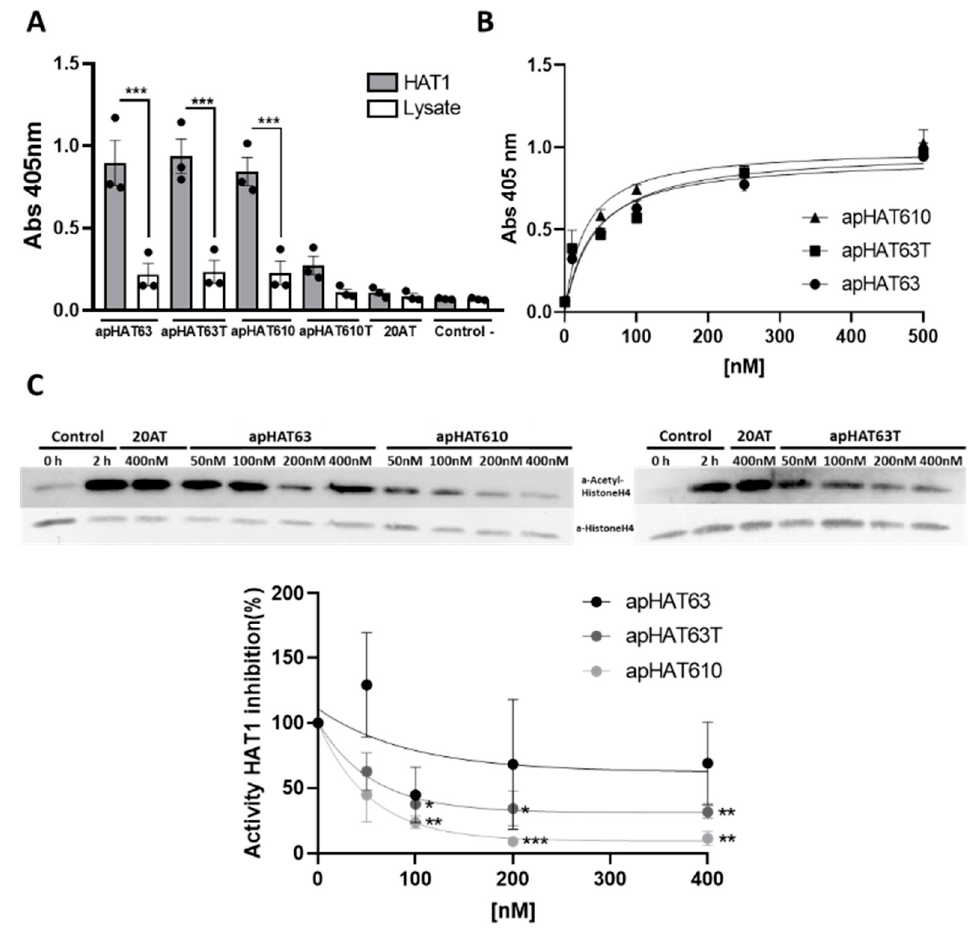
Figure 4. Characterization of the interaction of the selected aptamers with HAT1. ( A ) ELONA of the biotin-labeled synthetic aptamers at 40 nM (100 ng/well) against HAT1 and against a cell lysate previously adsorbed on p96 at 100 ng/well (2.5 pmoL/well). The graph represents the mean ± SEM of three independent experiments (*** p < 0.001 with respect to the lysate). ( B ) ELONAs of the biotin-labeled synthetic aptamers at concentrations from 0 to 500 nM versus HAT1 previously adsorbed on p96 at 100 ng/well (2.5 pmoL/well). The graph represents the mean ± SEM of three independent experiments. ( C ) Effect of aptamers on HAT1 activity. Immunodetection with specific antibodies against acetylated histone H4 following separation by 15% SDS-PAGE. Histone H4 levels were used as a loading control. The image corresponds to a representative assay. (Bottom) Quantification of acetylated histone H4 levels normalized according to histone H4 levels in electrophoresis and western blotting. Data are expressed as percentage inhibition with respect to the 2-h control. The graph represents the mean ± SEM of three independent experiments (* p < 0.05, ** p < 0.01, *** p < 0.001 relative to the control).